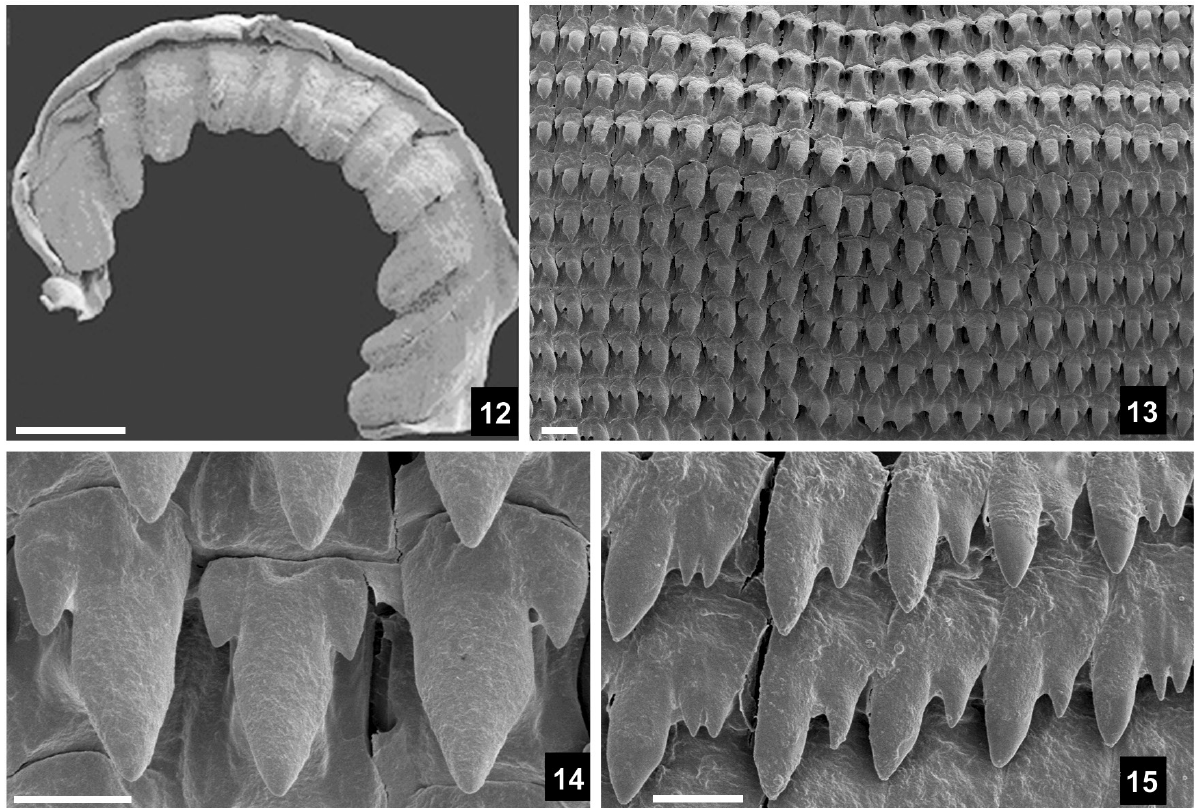
Figures 12–15. Scanning electron micrographs of the mandible and radula of Ventania avellanedae : (12) mandible; (13) radula; (14) central and lateral teeth; (15) marginal teeth. Scale bar: 12 = 0.20 mm, 13 = 0.02 mm; 14-15 = 0.01